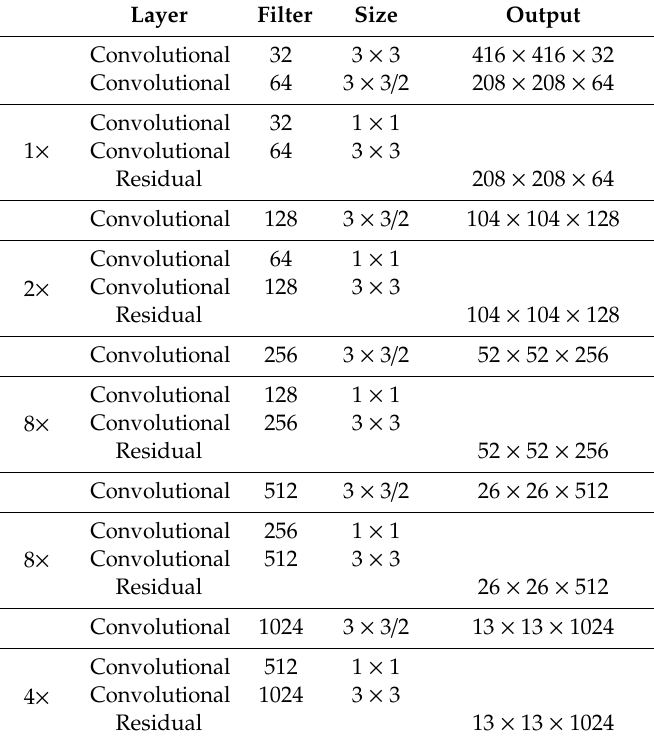
Table 1. The feature extraction network of You Only Look Once (YOLO)-V3.